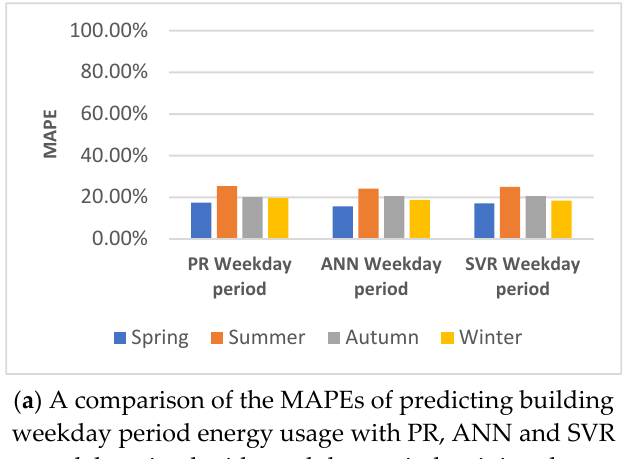
models trained with weekday period training data.